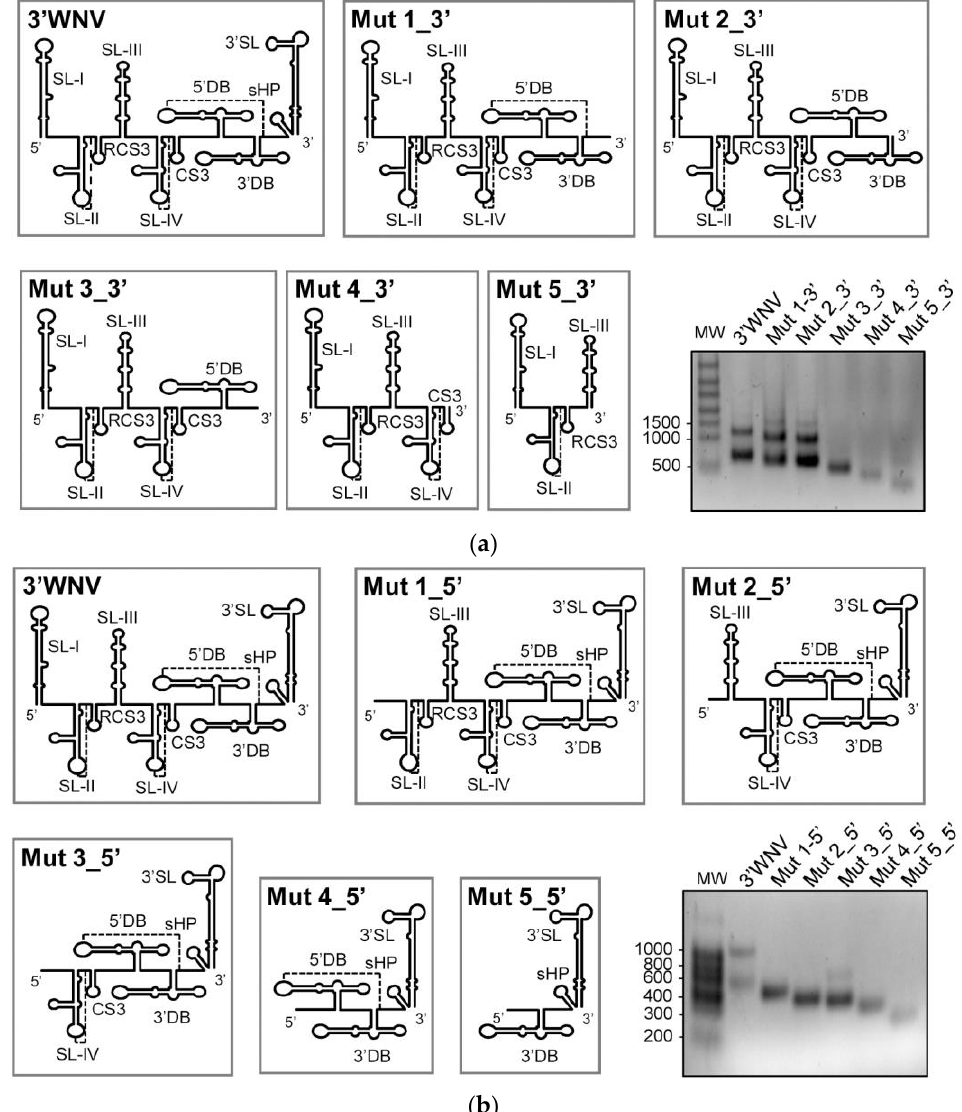
Figure 4. The elements SL-I and 3 ′ DB are critical for dimer formation. Consecutive deletions of the independent structural elements within 3 ′ WNV RNA were generated from the 3 ′ ( a ) and 5 ′ ( b ) ends to yield a collection of mutants that were assayed for their ability to dimerize, as described above. Different conformers were resolved as noted in Figure 2. Representative images of these assays are shown.